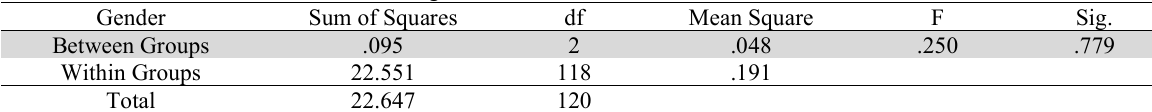
The results of ANOVA test for the effect of age Gender Sum of Squares df Mean Square F Sig. Between Groups .095 2 .048 Within